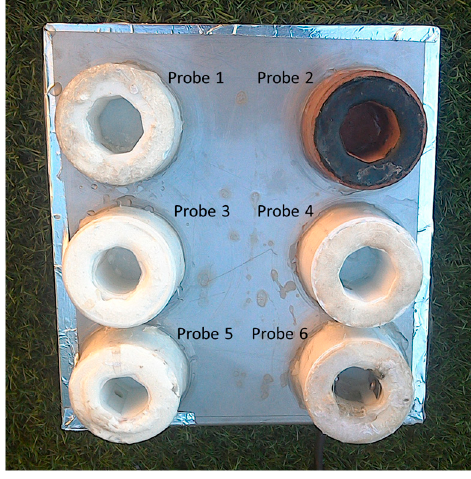
Figure 2. Anti-biofouling techniques probes. Probe 1: ABS material; Probe 2: PLA with copper filament; Probe 3: PDMS coating; Probe 4: PLA material; Probe 5: epoxy coating; Probe 6: chlorine production.